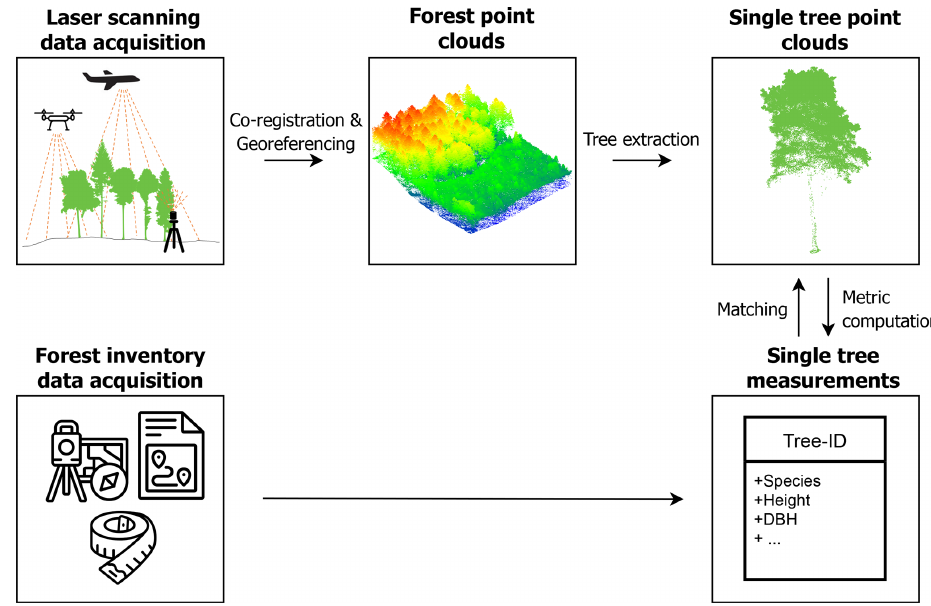
Figure 1. Workflow for the generation of the dataset, starting with the laser scanning data acquisition and forest inventory measurements and resulting in single-tree point clouds and corresponding point-cloud-derived and field-measured metrics. This figure has been designed using resources from http://www.flaticon.com/ (last access: 3 August 2021; Smashicons,